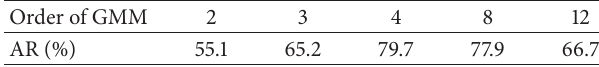
Table 3: Different model orders and